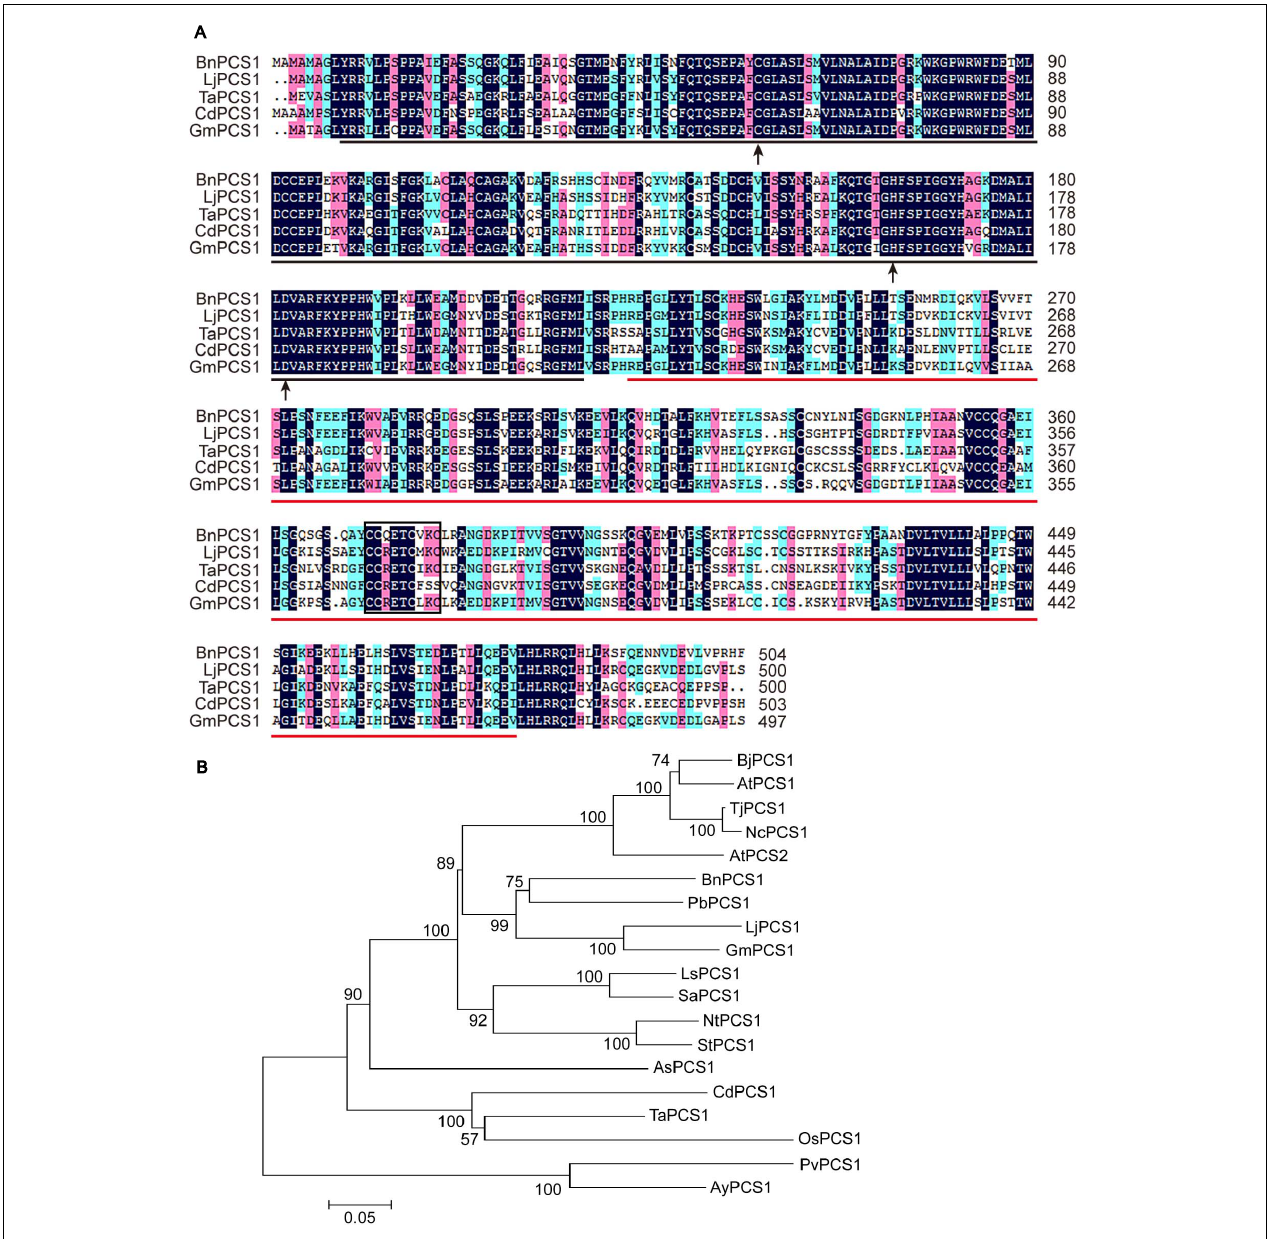
FIGURE 1 | Multiple sequence alignment and phylogenetic analysis of BnPCS1 and PCS proteins from other plant species. (A) Alignment of BnPCS1 and its orthologous proteins from various plant species constructed using DNAMAN 8.0 software. The shaded regions indicate the conserved amino acid residues (those shown in black are fully conserved; the amino acids highlighted in pink and light green are similar). The region underlined in black is the phytochetatin domain, and the phytochelatin_C domain is underlined in red. The three active sites are indicated by black arrows. The C 371 C 372 QETC 376 VKC 379 motif is enclosed in a black box. (B) Phylogenetic tree showing the evolutionary relationships between BnPCS1 and 18 other PCS proteins from various plant species constructed using the neighbor-joining (NJ) method in MEGA 5.0. The scale bar represents 0.05 amino acid substitutions per site. GenBank accession numbers of the proteins are as follows: AtPCS1 (AAD16046.1) and AtPCS2 (AAK94671.1) from Arabidopsis thaliana , BjPCS1 (CAC37692.1) from Brassica juncea , TjPCS1 (BAB93119.1) from Thlaspi japonicum , NcPCS1 (BAB93120.1) from Noccaea caerulescens , PbPCS1 (AEY68568.1) from Pyrus betulifolia , LjPCS1 (AAT80342.1) from Lotus japonicus ,